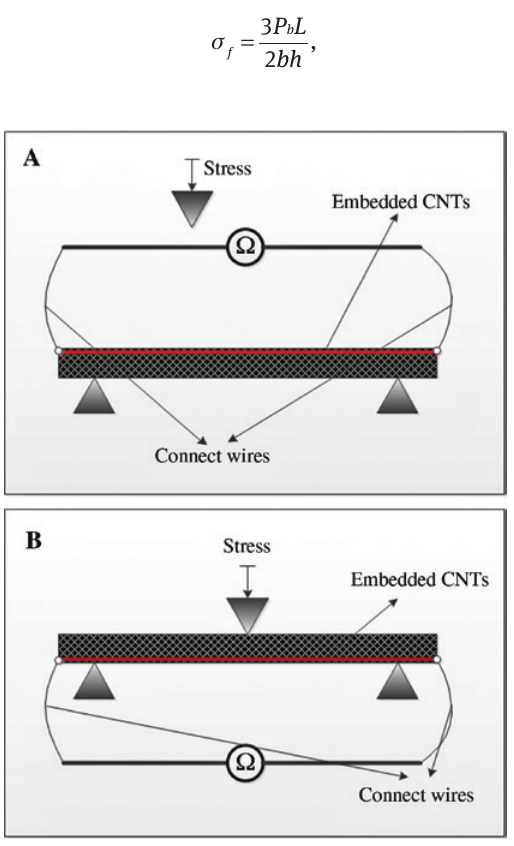
Figure 6: Schematic diagram of three point bending test for 3-D braided composites with CNTs sensor: (A) CNTs in compression area (embedded in the upper surface), (B) CNTs in tensile area (embed- ded in the lower surface).